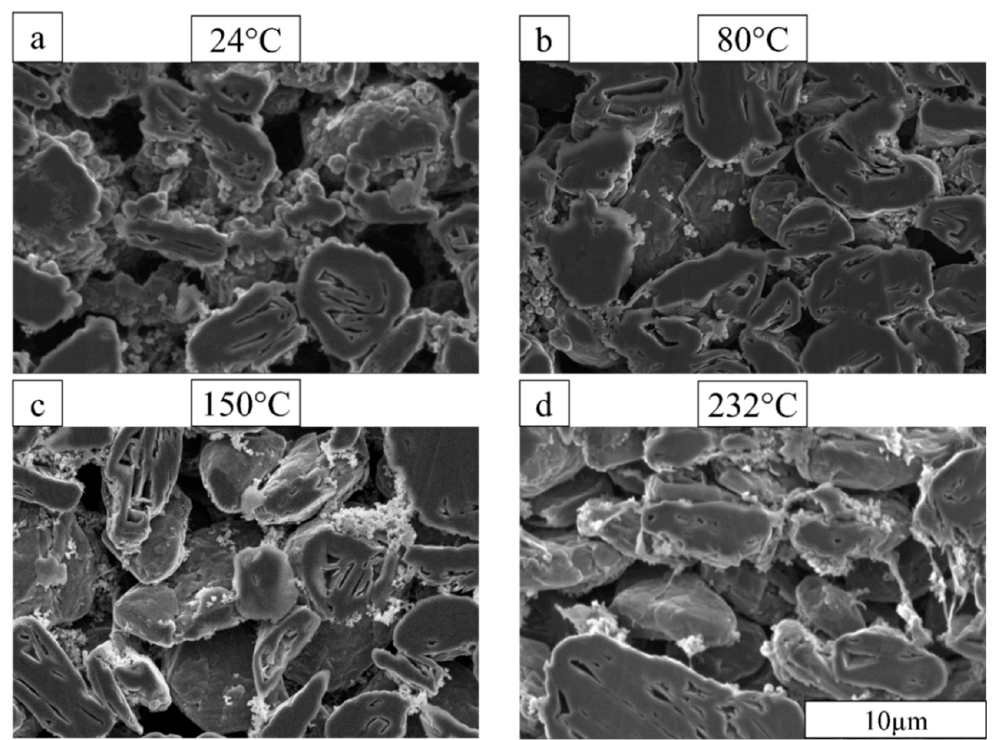
Figure 2. SEM cross-sectional images of the dried graphite anode at: ( a ) 24 °C; ( b ) 80 °C; ( c ) 150 °C; ( d ) 232 °C.